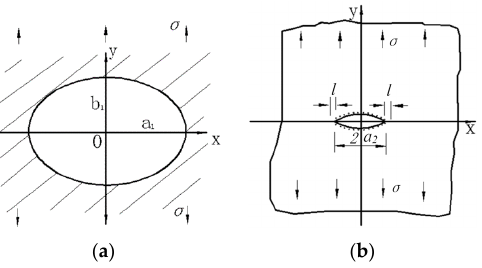
Figure 10. Elliptical hole defect of infinite ‐ plate model: ( a ) Elliptical hole in infinite plate; ( b ) Crack propagation.